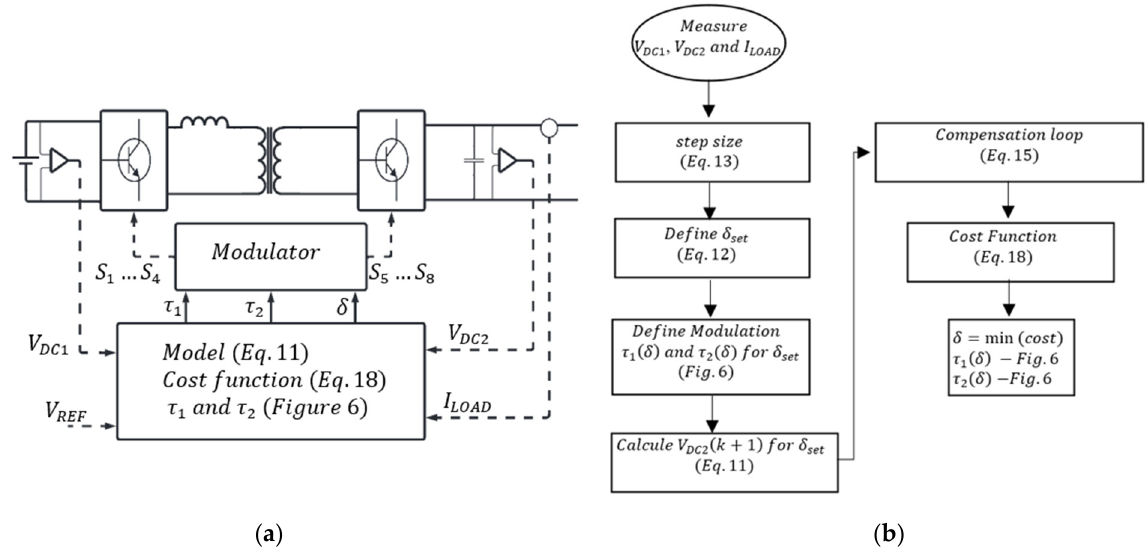
Figure 7. Control system ( a ) control strategy, ( b ) flow chart of AMPC.